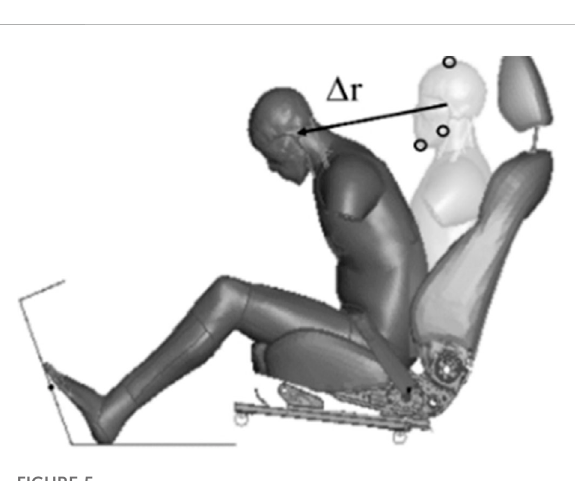
FIGURE 5 Relative displacement of the occupant